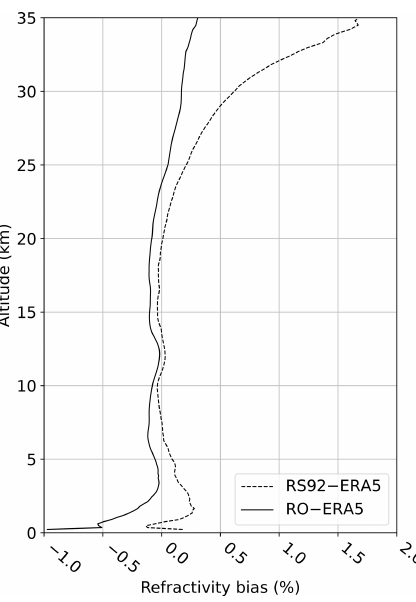
Figure 1. Global biases of RS92 and RO refractivity, with ERA5 used as reference, based on all collocation triplets (collocated ERA5, RO, and RS profiles) used in this study, evaluated at the RO reference location. See also Sect. 2. Percentages are calculated relative to the mean of ERA5 forecasts.